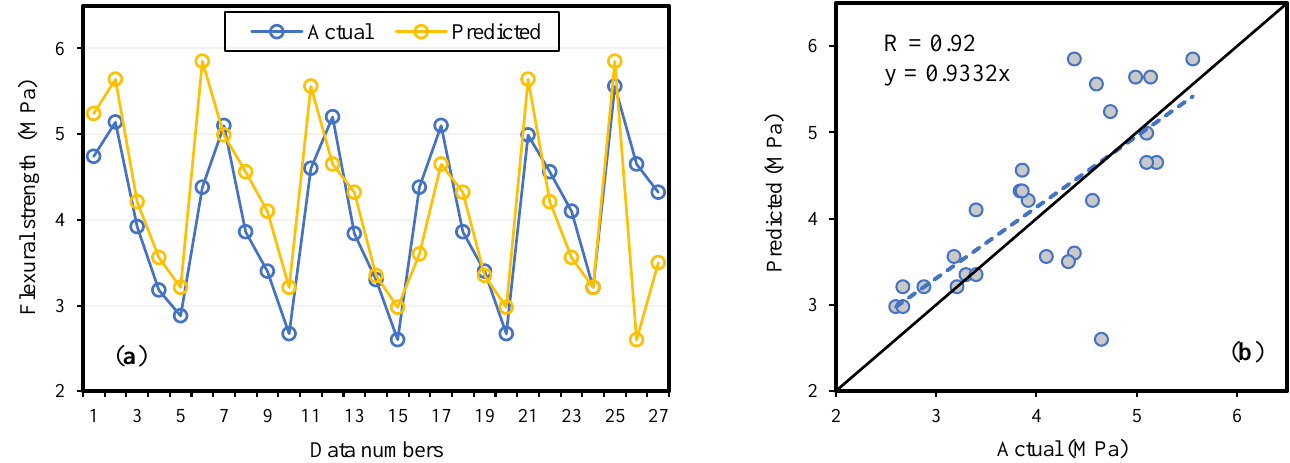
Figure 8. Flexural strength (f FS ) model validation by experimental results ( a ) variation in data ( b ) scattered plot.